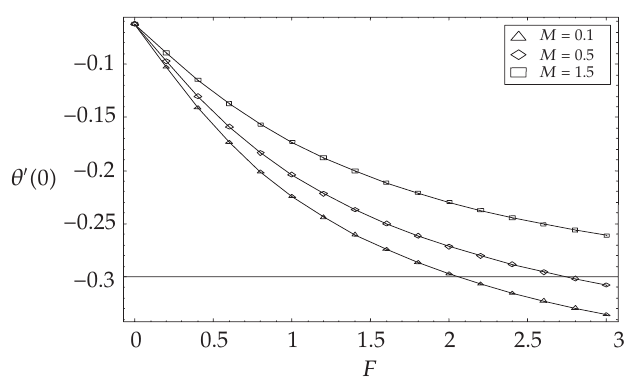
Figure 4.1 . Variation of the heat flux θ (cid:6) ( 0 ) with F and M parameters.